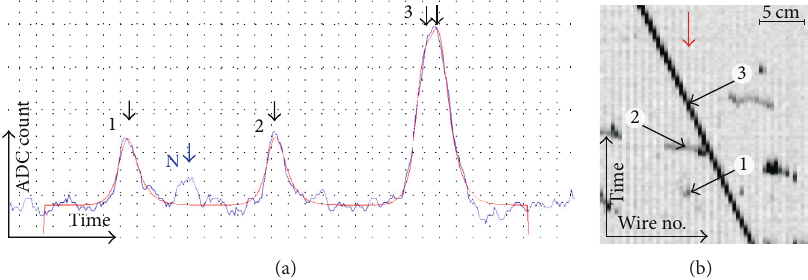
Figure 3: Data: Collection wire signal fragment: (a) raw ADC (blue) and the fit function (red); (b) fragment of the 2D wire view; red arrow indicates the wire shown in (a). Hits (1, 2) are induced by the tracks perpendicular to the wires and are fitted with single pulses; hit (3) is induced by the track more parallel to the wires; this hit was split into two hits in the second stage of the hit reconstruction algorithm. The feature marked with (N) in the raw ADC is too low to be recognized as hit during the signal fit optimization.